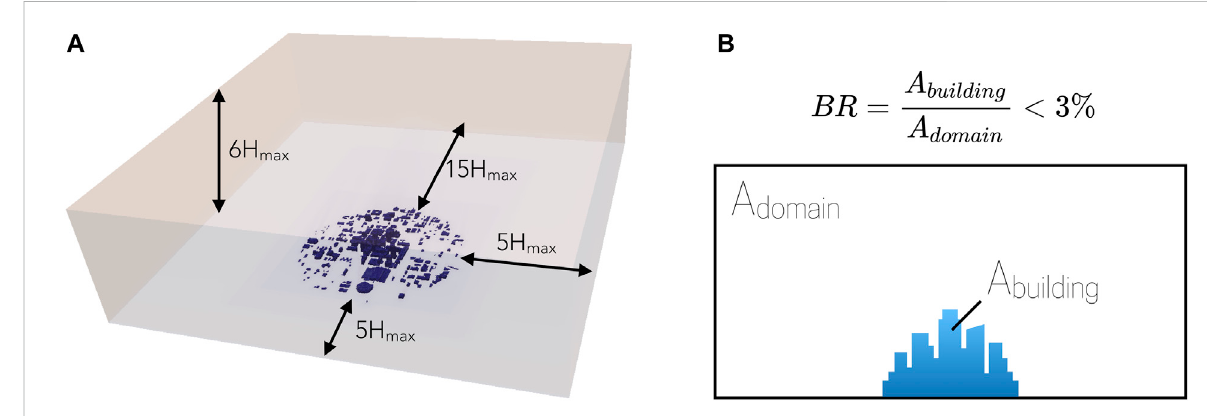
FIGURE 8 Typical guidelines for a domain size, adapted from Blocken